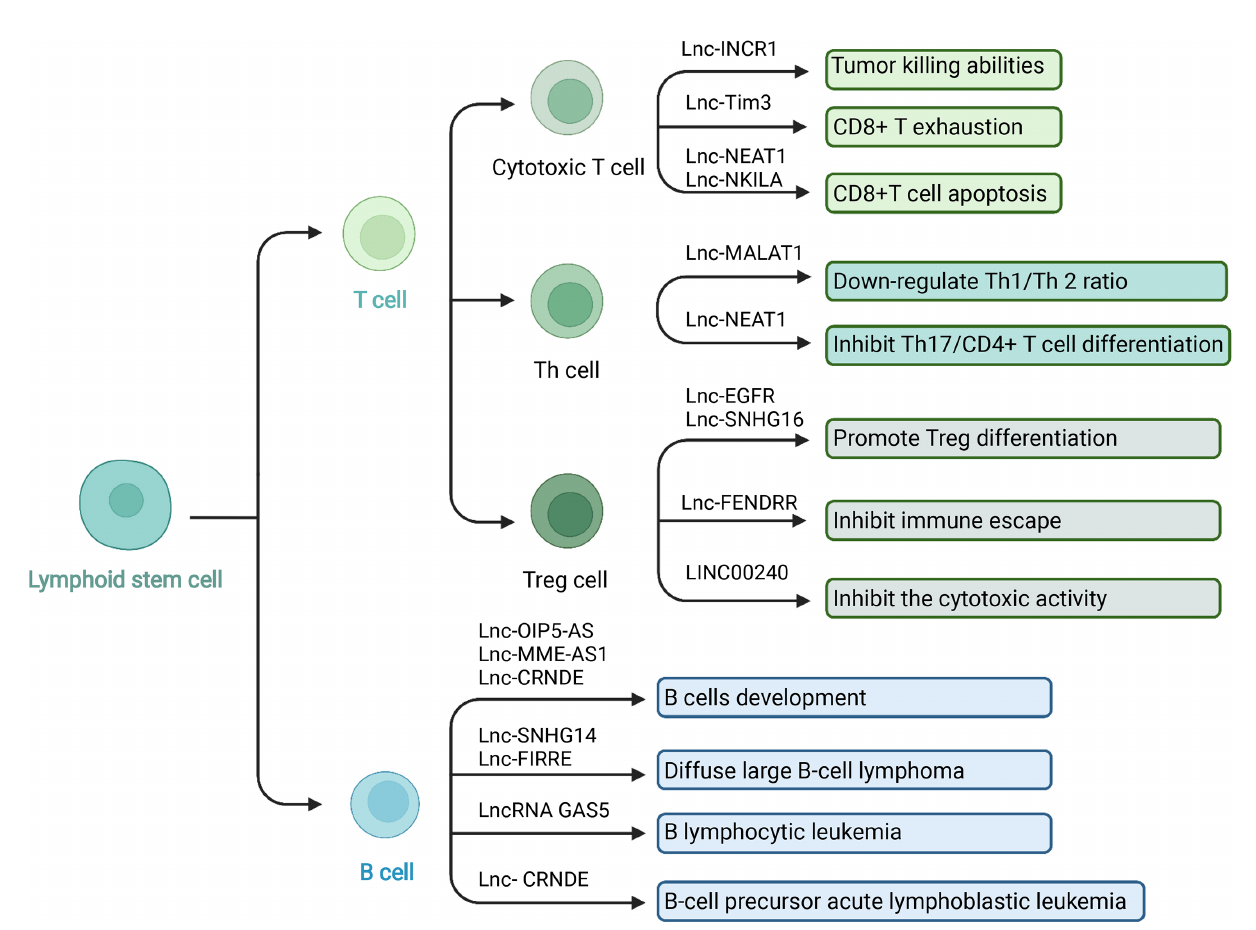
FIGURE 3 | LncRNA and adaptive immune cells in TIME. In the TIME, lncRNA can regulate adaptive immune cells to interact with tumor cells. T cells and B cells are the main adaptive immune cells. T cells play different immunomodulatory effects depending the various subgroups. Cytotoxic T cells have the tumor killing abilities and Treg cells play an immunosuppressive role. LncRNA has been revealed to participate in adaptive immune cells ’ development, activation, differentiation, function, and cancer immunology. Created with